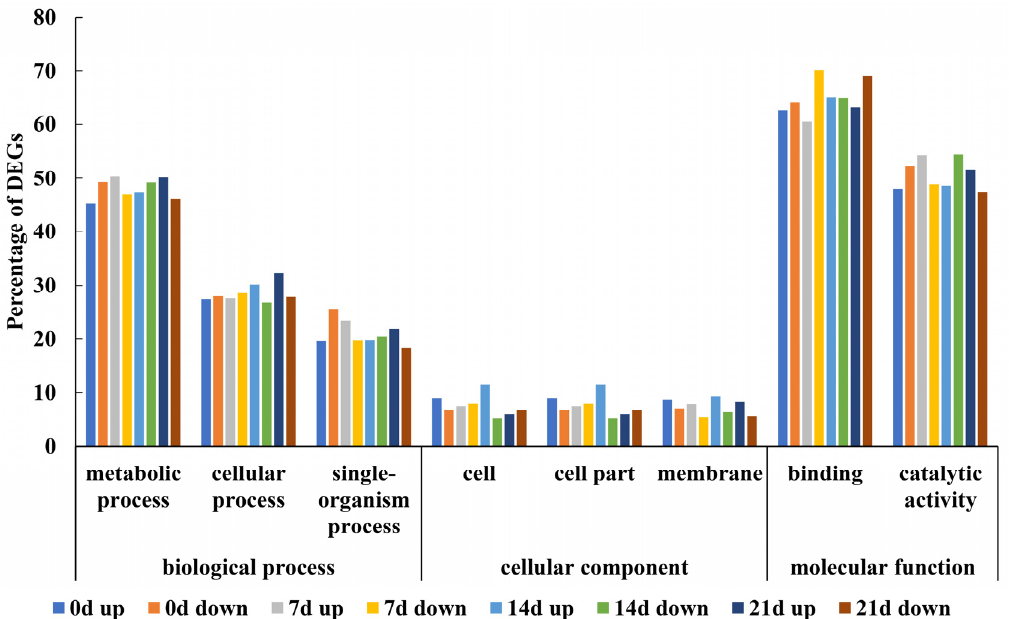
Figure 3. Major GO analysis of DEGs at different time points in each category. Metabolic process, cellular process, and single-organism process belong to the biological process category. Cell, cell part, and membrane belong to the cellular component category. Binding and catalytic activity belong to the molecular function category.